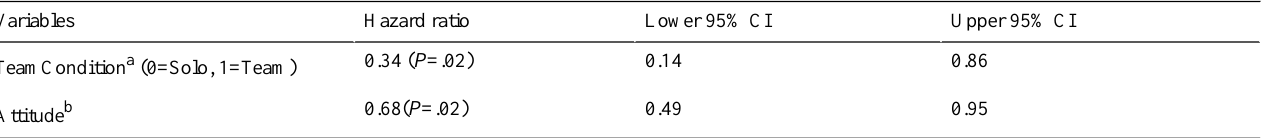
Table 3. Results of the survival